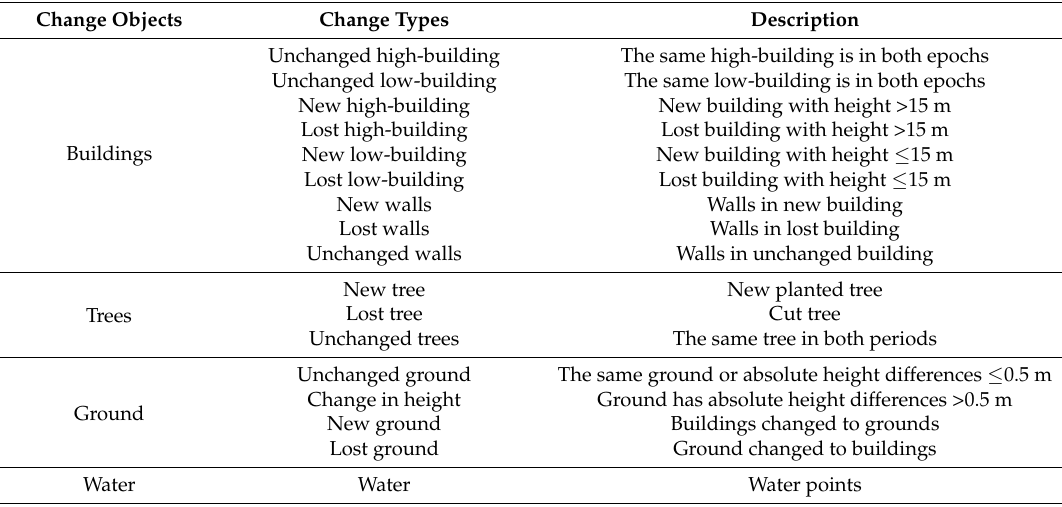
Table 2. Rules of taking sample for machine learning classification.